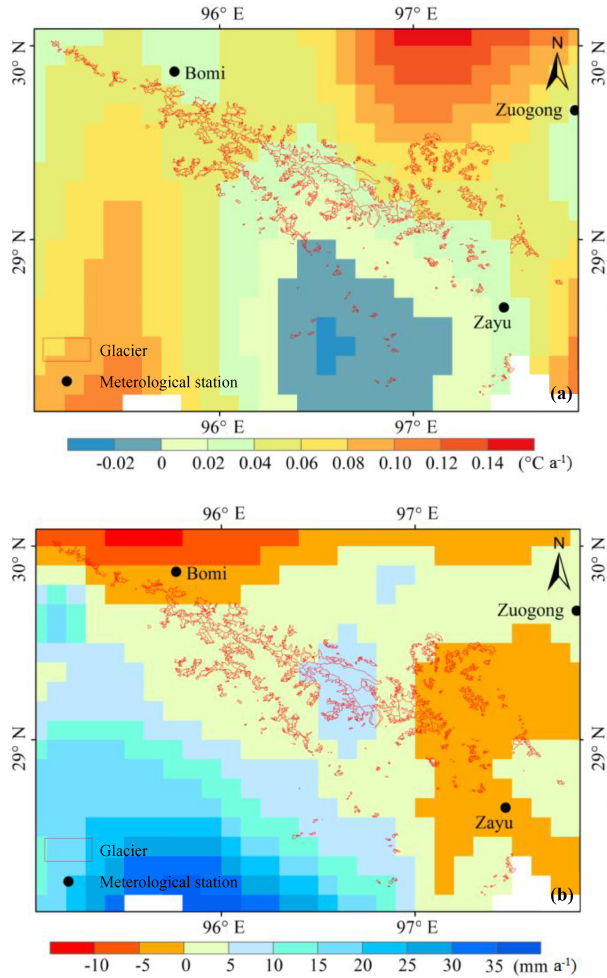
Figure 9. The changes of temperature and precipitation (from May to September) in the Kangri Karpo during 1979–2012. (a) Temper- ature, (b)